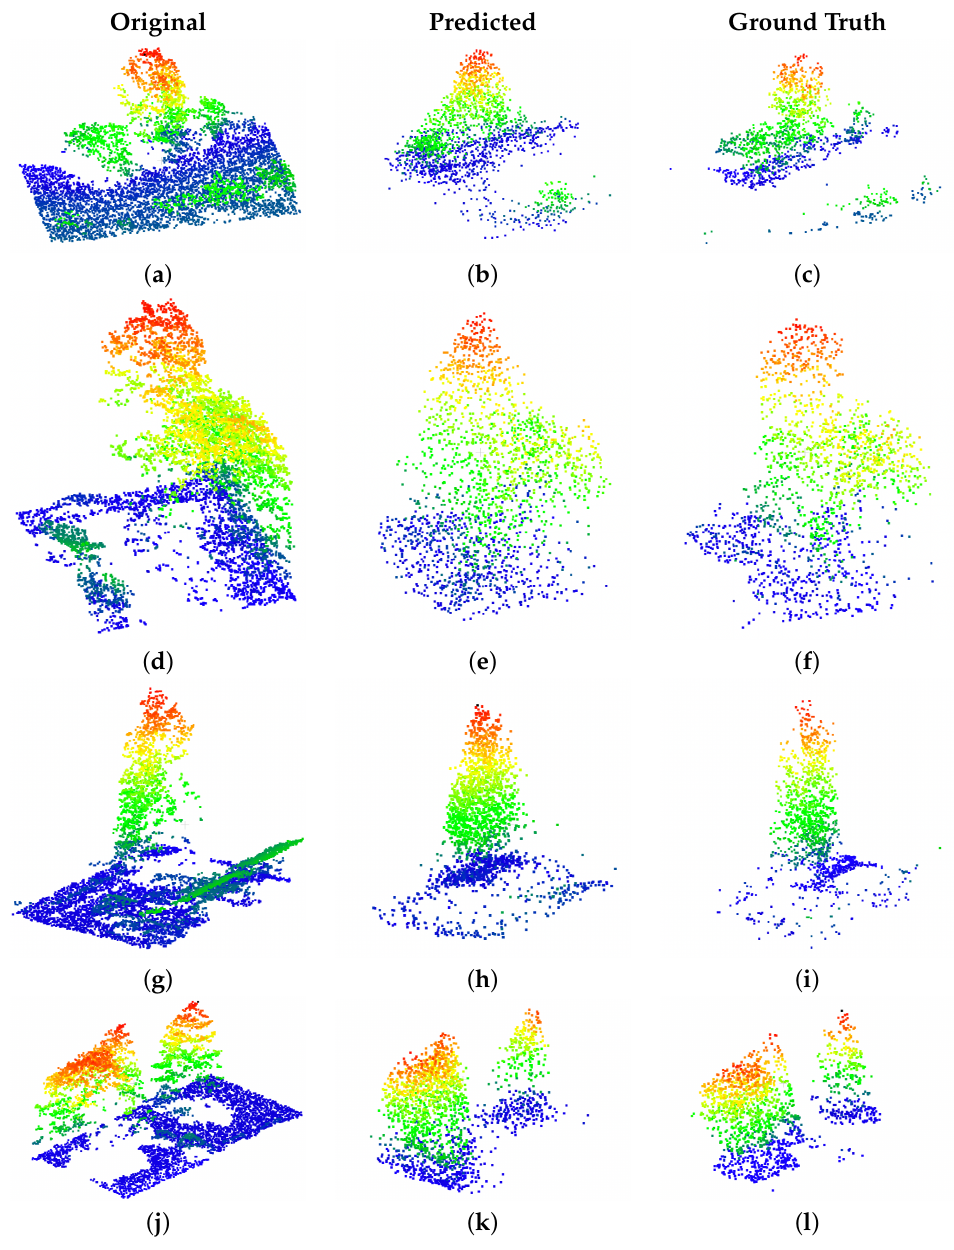
Figure 12. The above image shows examples of areas of occlusion that have been reconstructed with our method using the DALES Viewpoints Version 2 dataset. All point clouds are colored by height. The initial input point clouds are in the left-hand column, our predicted point clouds are in the middle column, and the right-hand column depicts the ground